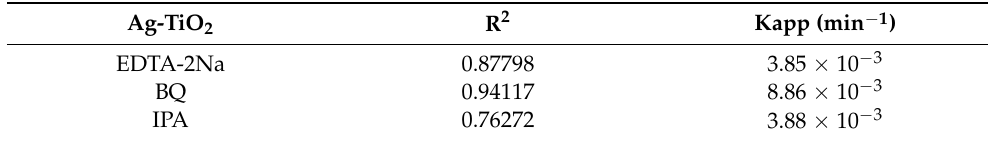
Figure 13. ( a ) Photocatalytic degradation curves of RhB in the presence of Ag-TiO 2 and the radicals’ scavengers (ethylenediaminetetraacetic acid disodium salt (EDTA-2Na), benzoquinone (BQ) and isopropanol (IPA)). The data represent means ± standard deviation from three experiments. In these series of experiments, * p < 0.05 was considered statistically significant. ( b ) Photocatalytic kinetics of the same samples, according to a linear pseudo-first-order model.